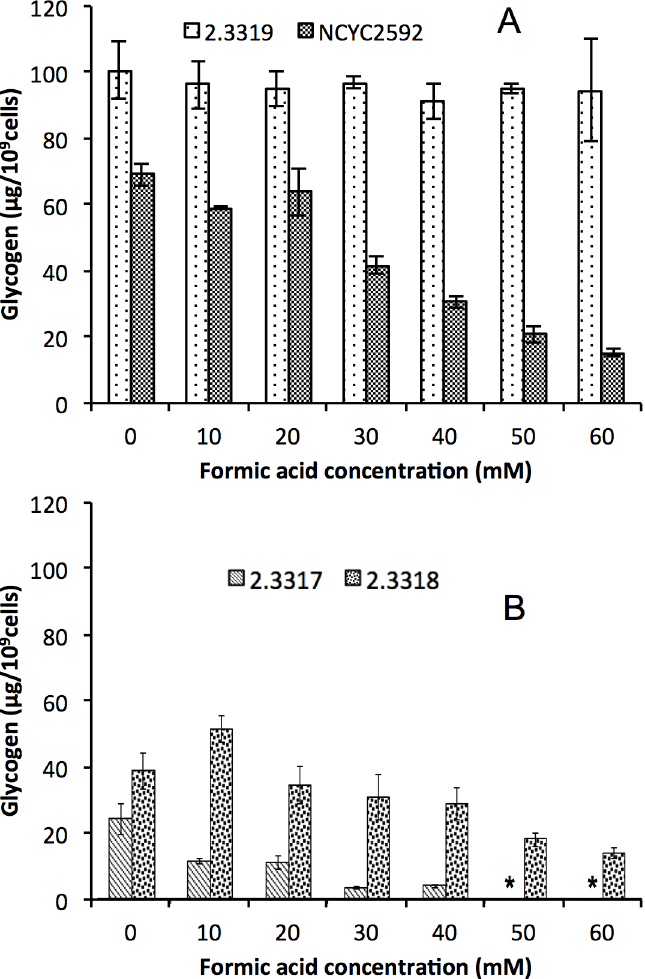
Fig 7. Intracellular glycogen accumulation by Saccharomyces cerevisiae NCYC 2592 and Saccharomyces arboricolus 2.3319 (A), and Saccharomyces arboricolus 2.3317 and Saccharomyces arboricolus 2.3318 (B) in the presence of formic acid (0 – 60 mM) using YPD medium. Fermentation was carried out under anaerobic condition, incubated at 30°C and samples were analyzed after 24 hours. Values are the mean of three experiments and vertical error bars represent standard deviation. * - Data are not